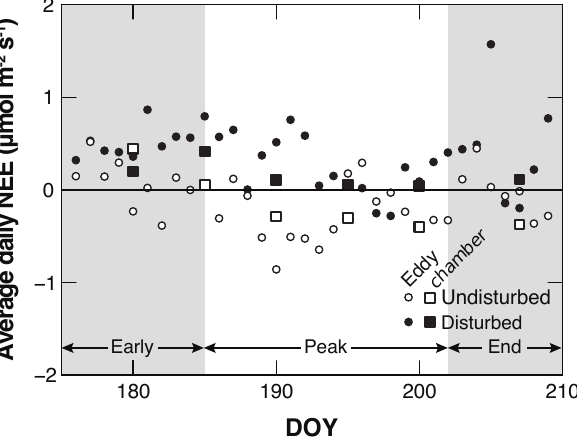
Figure 7. Comparison of NEE measurements from static chamber (square) and calculated from the two EC systems (circle). Open symbols represent measurements from undisturbed tundra, while closed symbols are measurements in the disturbed areas. Measure- ments were made in 21 collars in each of the disturbed and both undisturbed footprint areas of the EC towers.